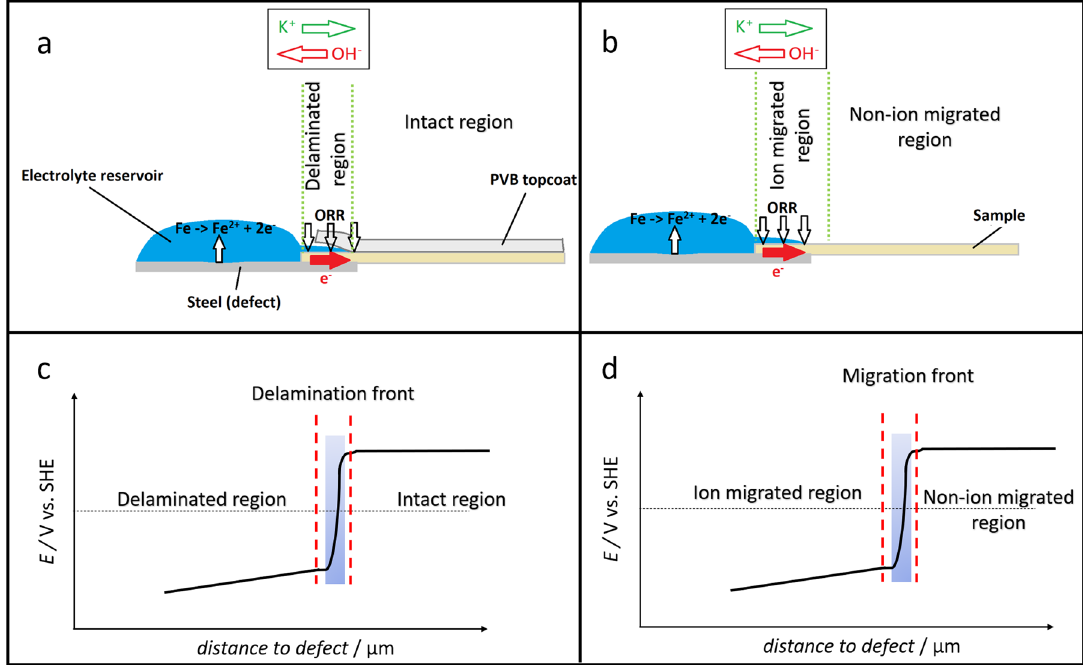
Fig. 1 Mechanism of cathodic delamination and electrolyte spreading. Schematic explaining the mechanisms and regions established during a cathodic delamination and b cathodic electrolyte spreading. Typical sigmoidal electrode potential ( E ) vs. distance curves obtained from SKP measurements, depicting various regions established during the progress of c cathodic delamination and d cathodic electrolyte